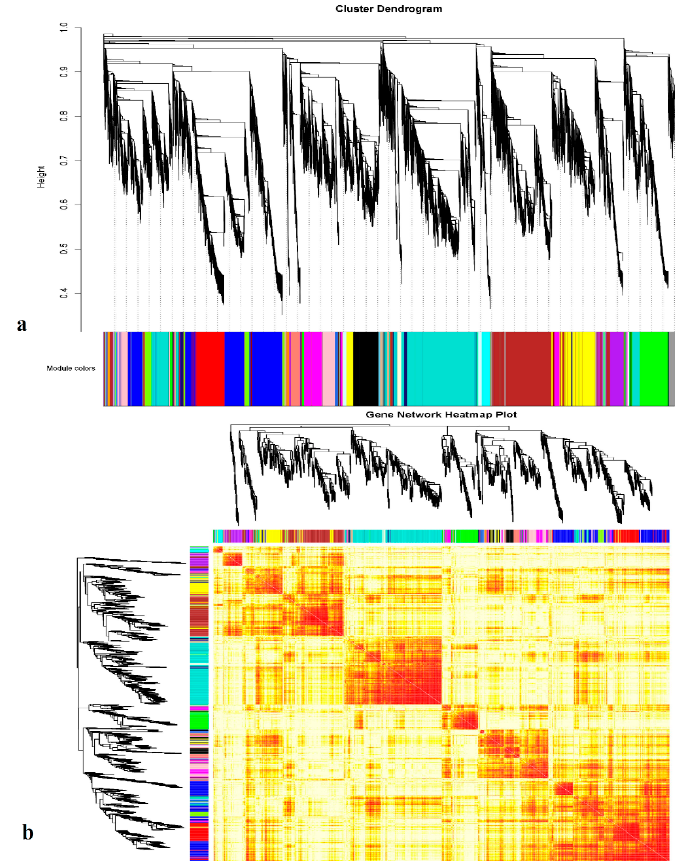
Figure 8. ( a ) Weighted gene co-expression network analysis (WGCNA), all expressed genes in Gbgl, Gbdd, Ga24h and Ga48h RNA-seq samples, showing hierarchical dendrogram co-expression of identified modules by WGCNA; each leaf represents a single gene. ( b ) The heat map plot of the gene network analysis. Dark red color shows overlap of highly expressed genes which pair from respective datasets, and the lighter color represents the low overlap genes. Different modules are indicated by the diagonals .